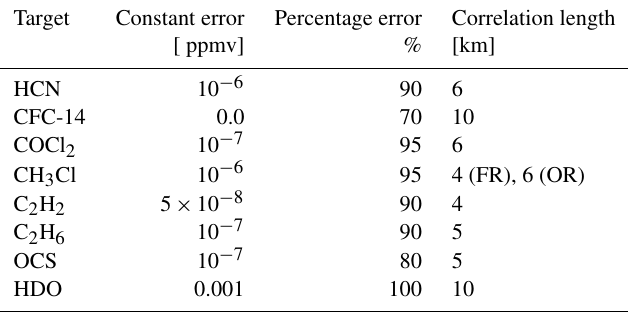
Table 2. Size of the a priori errors and correlation lengths used in the